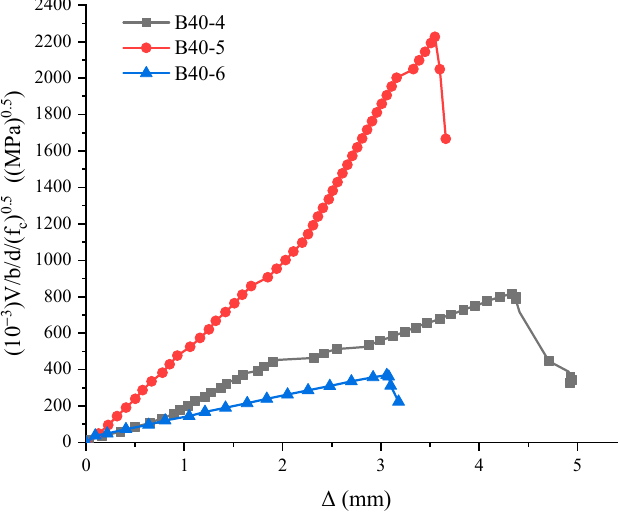
Figure 11. Effect of λ on load–deflection curves for C40 concrete.